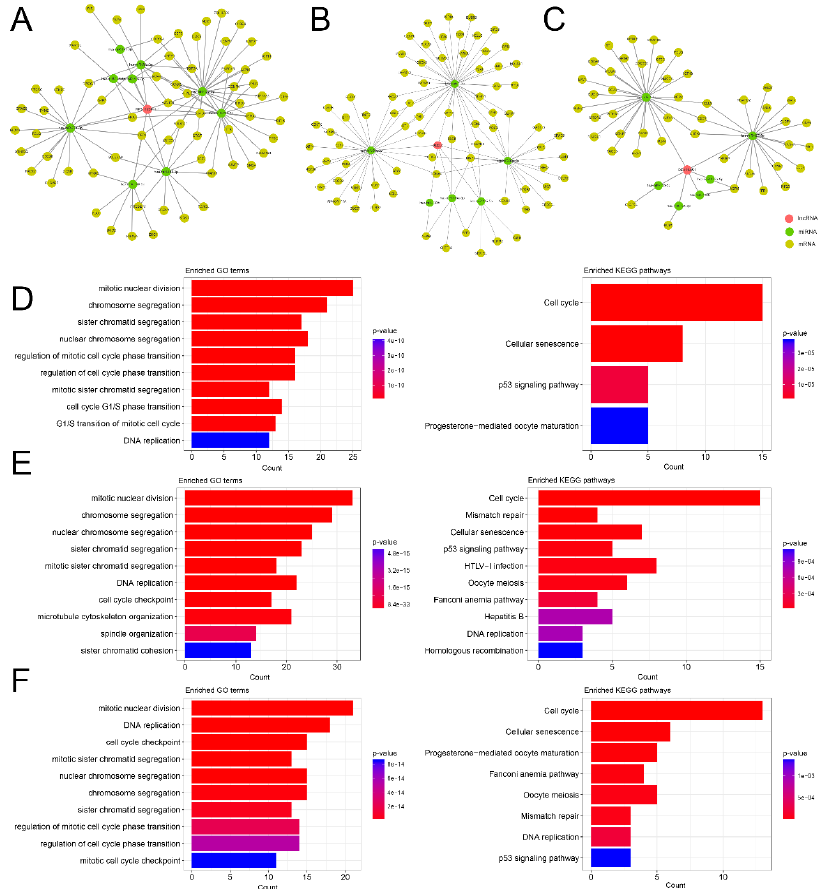
Figure 4. The ceRNA subnetworks and functional enrichment analysis of the hub lncRNAs. ( A ) The RP5-1120P11 -associated ceRNA subnetwork; ( B ) DLEU2 -associated ceRNA subnetwork; ( C ) DDX11-AS1 -associated ceRNA subnetwork. The lncRNA, mRNA, and miRNA were colored red, yellow, and green; ( D ) The enrichment analysis result of RP5-1120P11 -associated ceRNA subnetwork; ( E ) The enrichment analysis result of DLEU2 -associated ceRNA subnetwork; ( F ) The enrichment analysis result of DDX11-AS1 -associated ceRNA subnetwork. The count indicates the number of genes associated with a GO term in BP or a KEGG